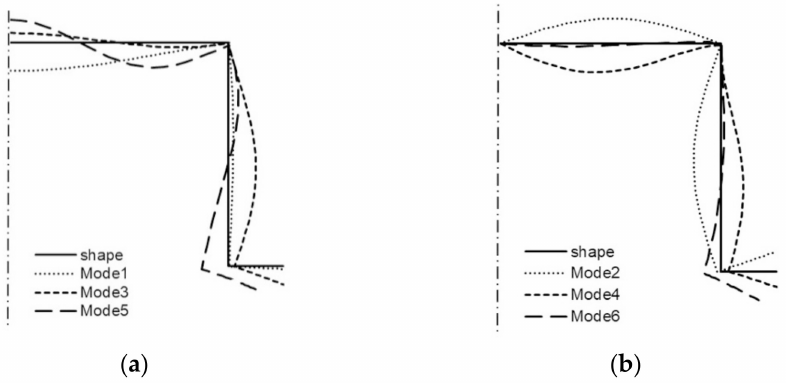
Figure 14. Buckling modes of the TH-channel of the total length 80 mm: symmetrical modes 1, 3, 5